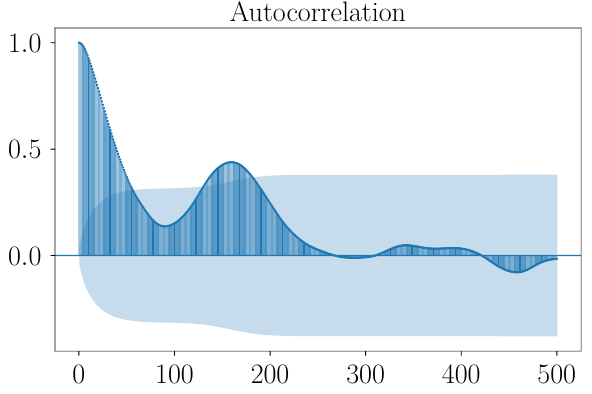
Figure 40. Autocorrelation function of measured velocity component in x -direction for sensor 11.